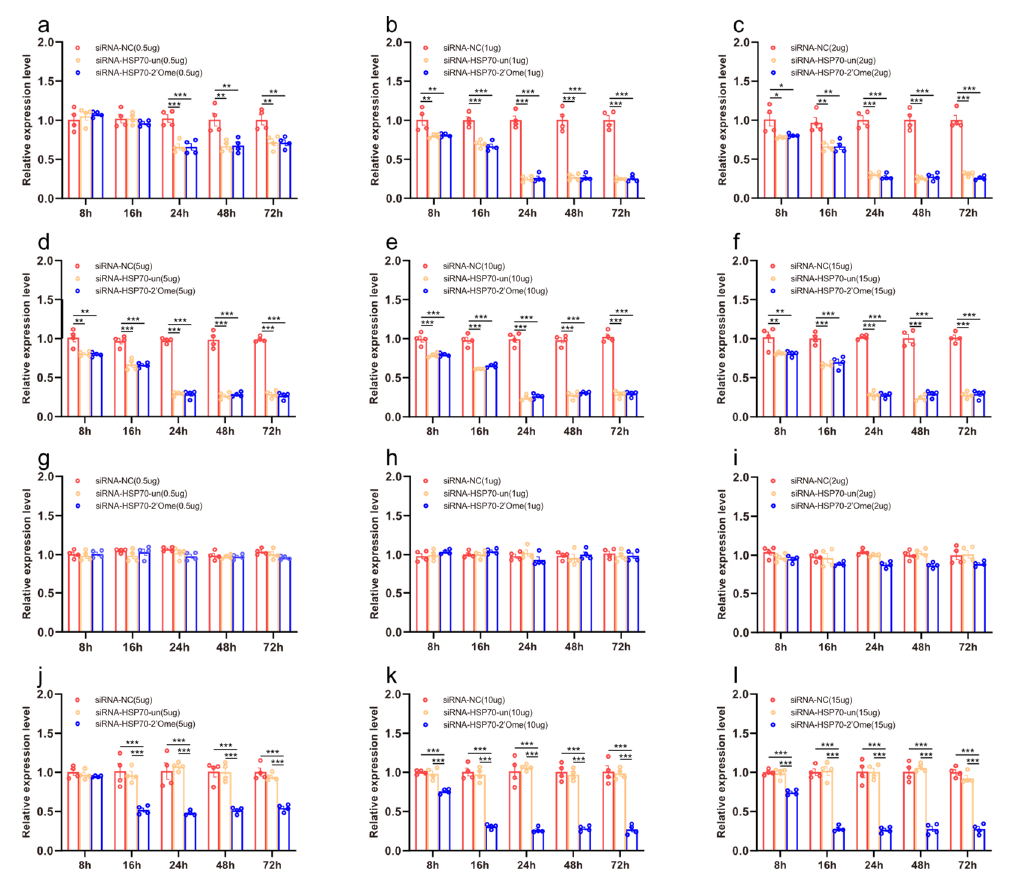
Figure 4. The effects of siRNA on HSP70 mRNA transcripts in honey bee brains. The mRNA levels of HSP70 were analyzed at 8 h, 16 h, 24 h, 48 h, and 72 h after injection of 0.5 μ g ( a ), 1 μ g ( b ), 2 μ g ( c ), 5 μ g ( d ), 10 μ g ( e ), and 15 μ g ( f ) siRNA, or after feeding of 0.5 μ g ( g ), 1 μ g ( h ), 2 μ g ( i ), 5 μ g ( j ), 10 μ g ( k ), and 15 μ g ( l ) siRNA. The red column shows the relative expression of siRNA-NC injected. The orange column shows the relative expression of siRNA-HSP70-un injected. The blue column shows the relative expression of siRNA-HSP70-2 ′ Ome injected. Each circle represents a biological repeat. * Indicates p < 0.05, ** indicates p < 0.01, *** indicates p < 0.001, tested by ANOVA test. Detailed data are shown in Table S4.